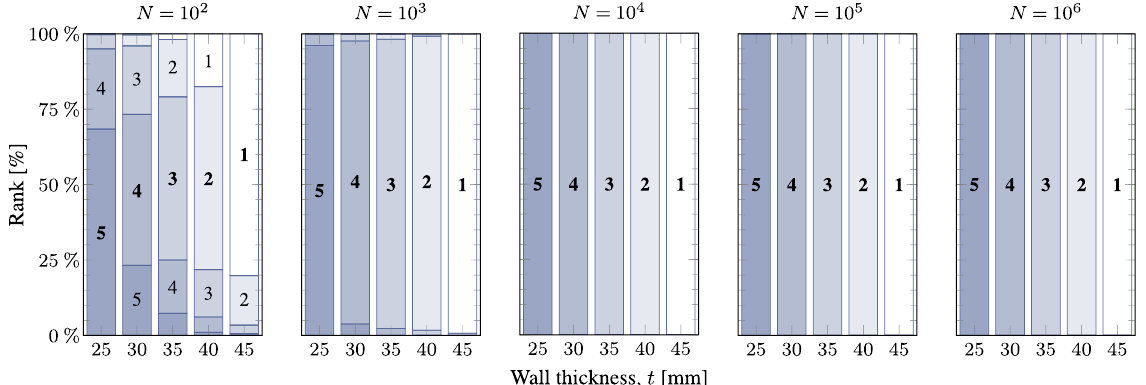
Figure 16. Ranking of five wall thicknesses on the basis of a 50-year stress level using a fitting-before-aggregation approach with a Gumbel fitted above a threshold with different sample